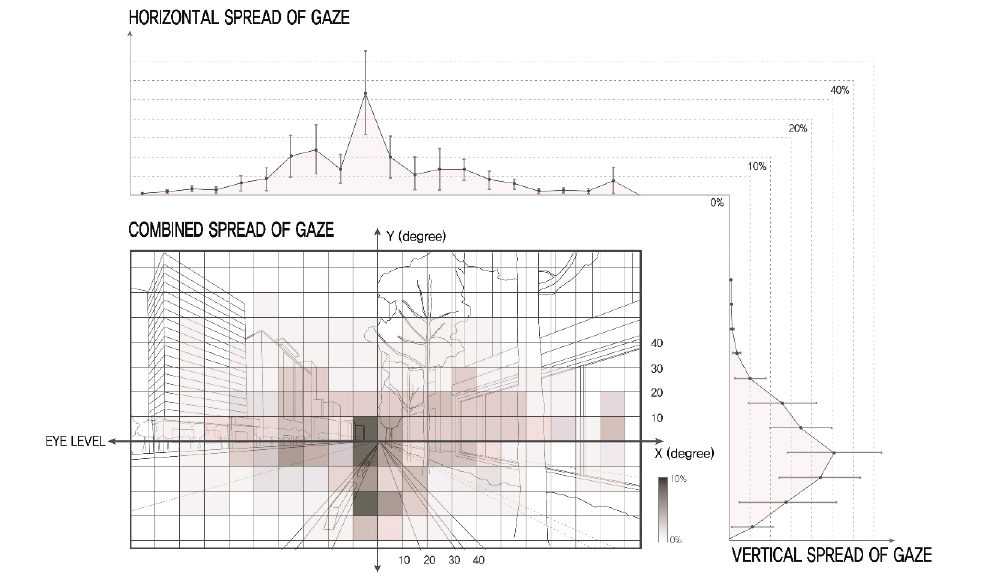
Figure 4. Horizontal, vertical and combined gaze dispersion